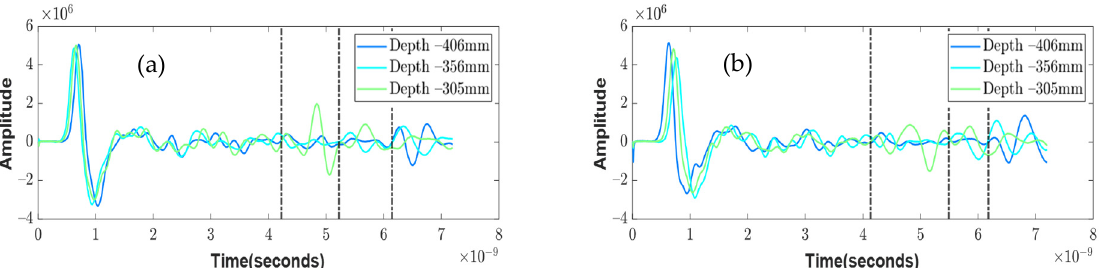
Figure 11. Experimental wave responses result of the di ff erent size of aggregates 12–25 mm ( a ), and 25–50 mm ( b ), at three di ff erent depths .